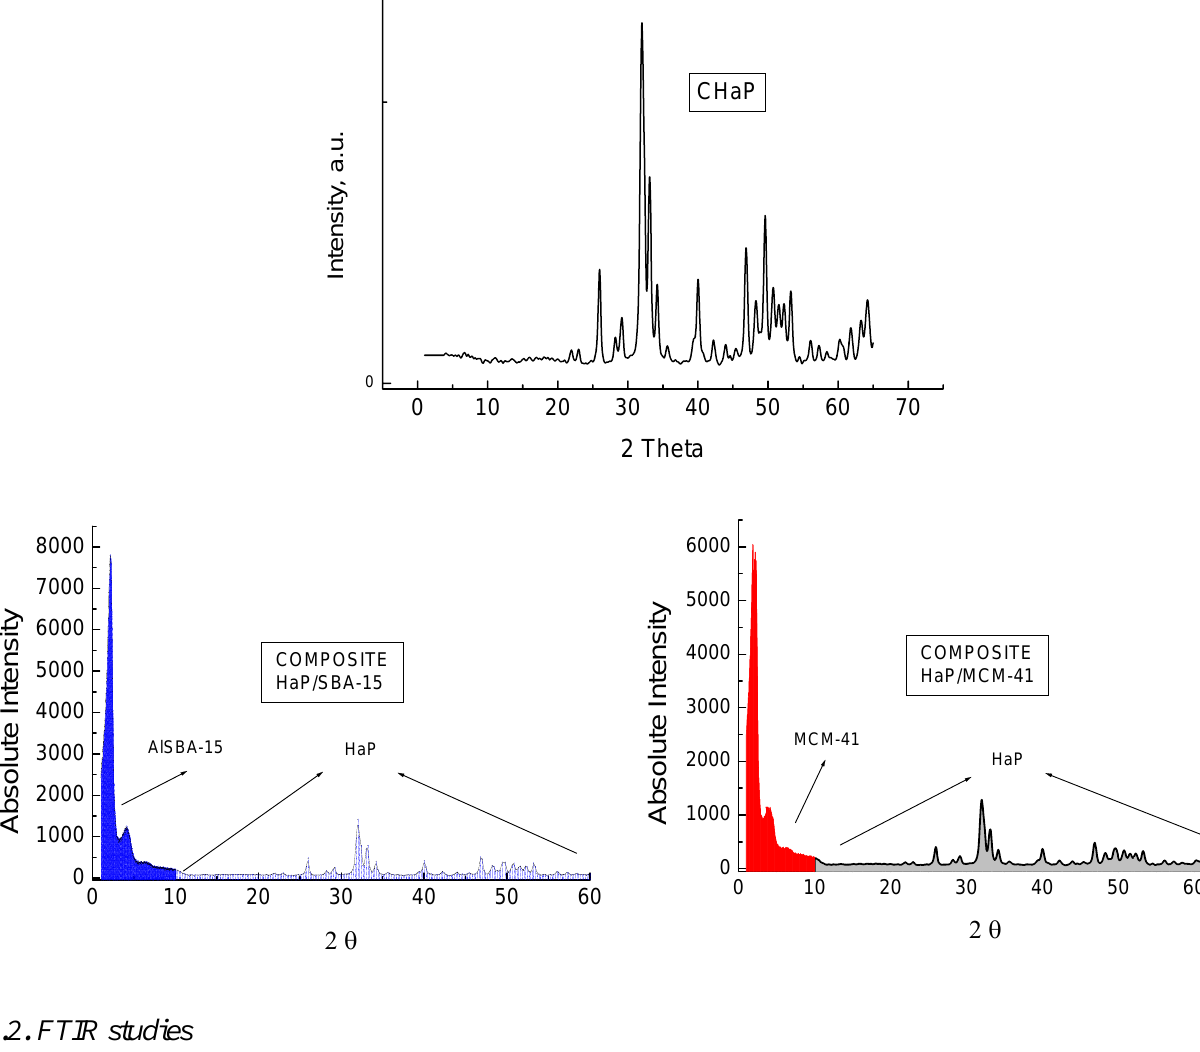
Figure 2. XRD of CHaP, HaP/SBA-15 and